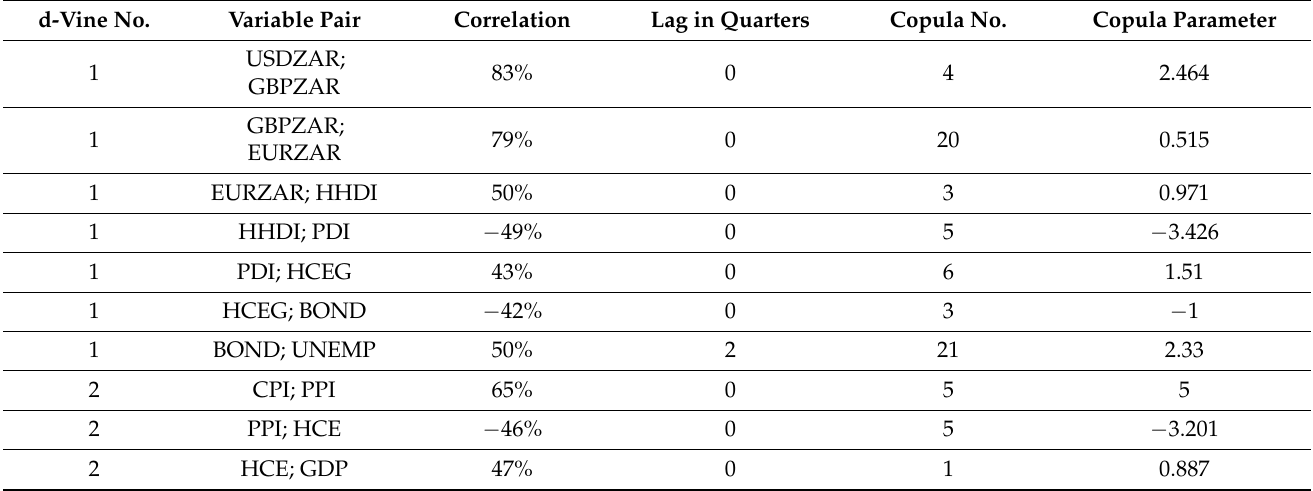
Table 4. Estimated parameters of the multivariate d-vine dependence